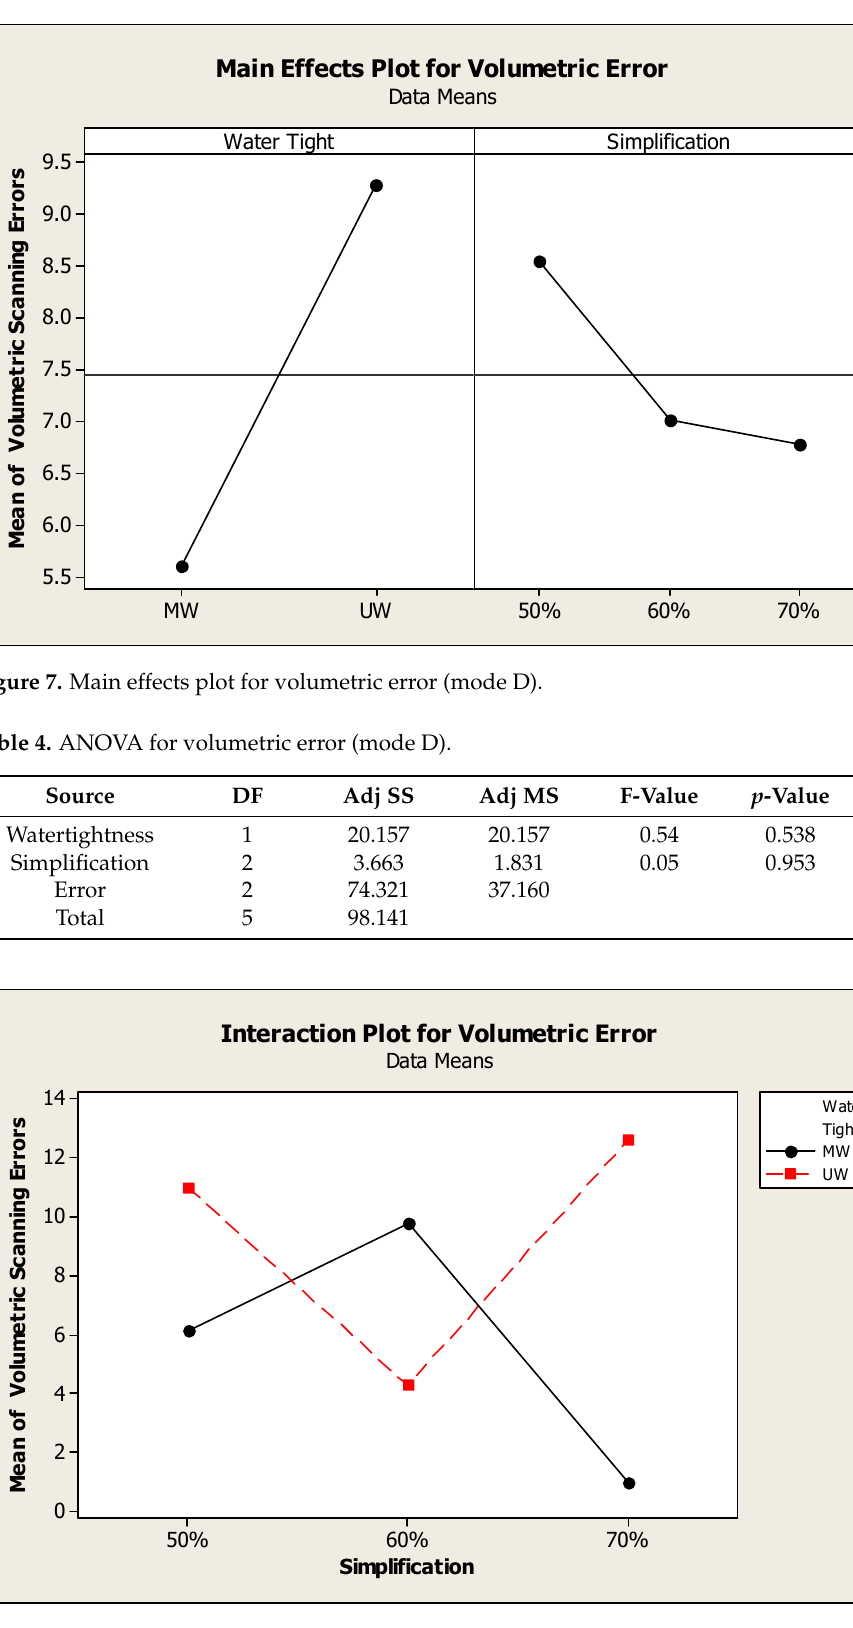
Table 4. ANOVA for volumetric error (mode D).